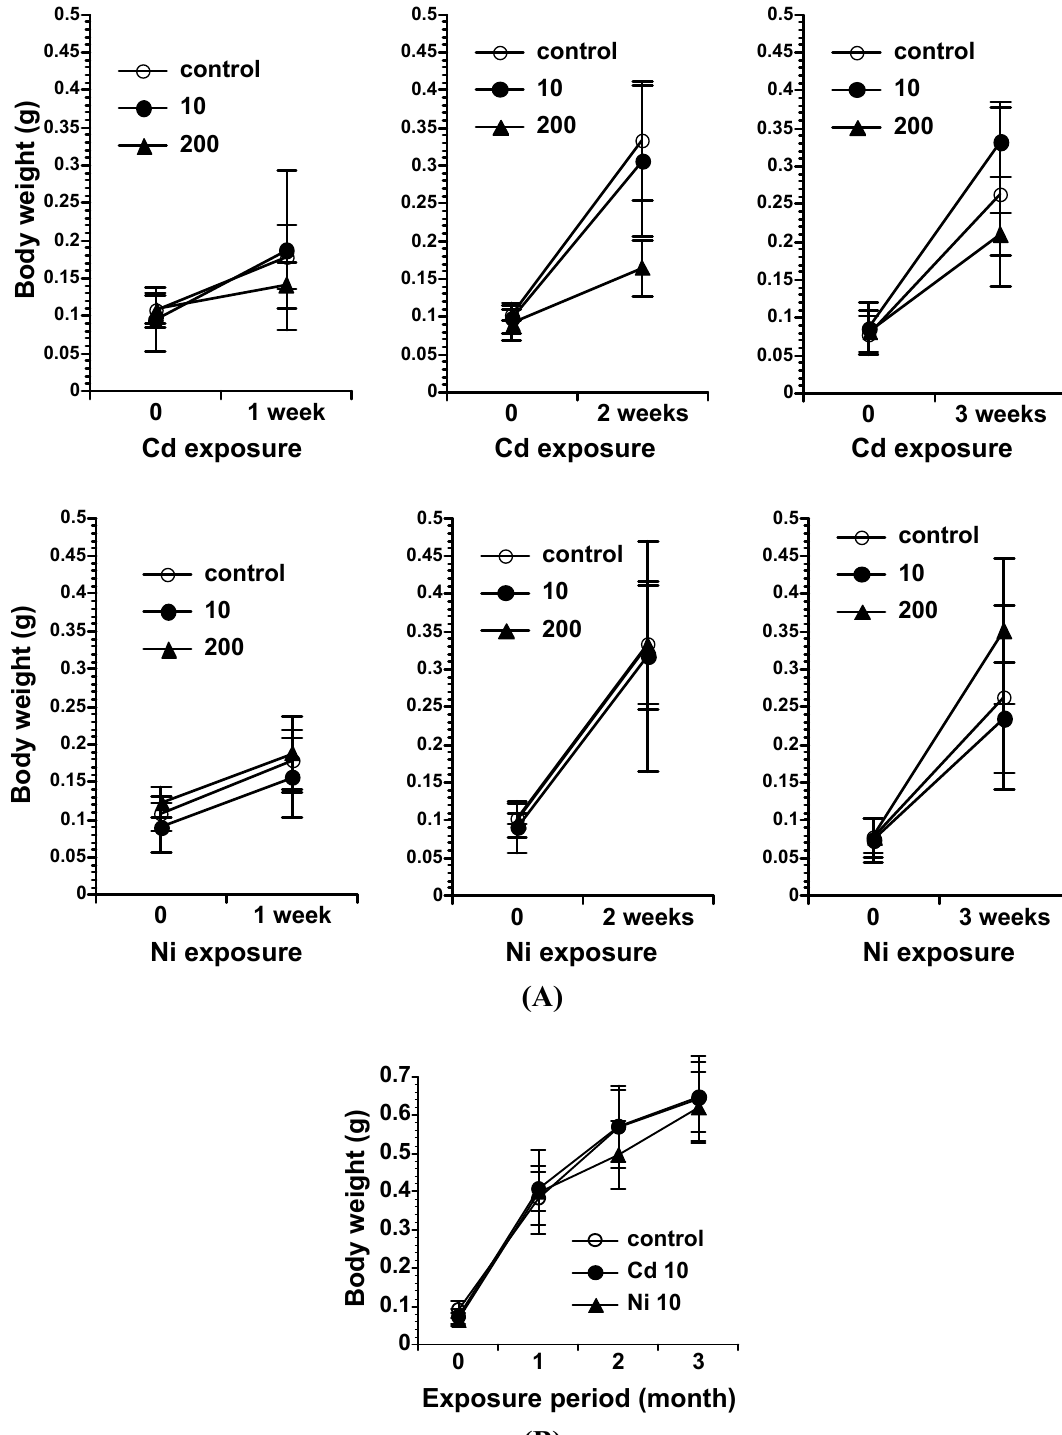
Figure 1. All E. fetida were weighed under wet conditions in the short-term (A) and the long-term (B) experiments. Each data point represents the mean of six E. fetida . The treatment of E. fetida with 200 μ g Cd/g soil resulted in body weight loss, suggesting Cd-induced growth inhibition. In the long-term experiment, each data point represents the mean of 16 E. fetida , and no significant differences between any groups were